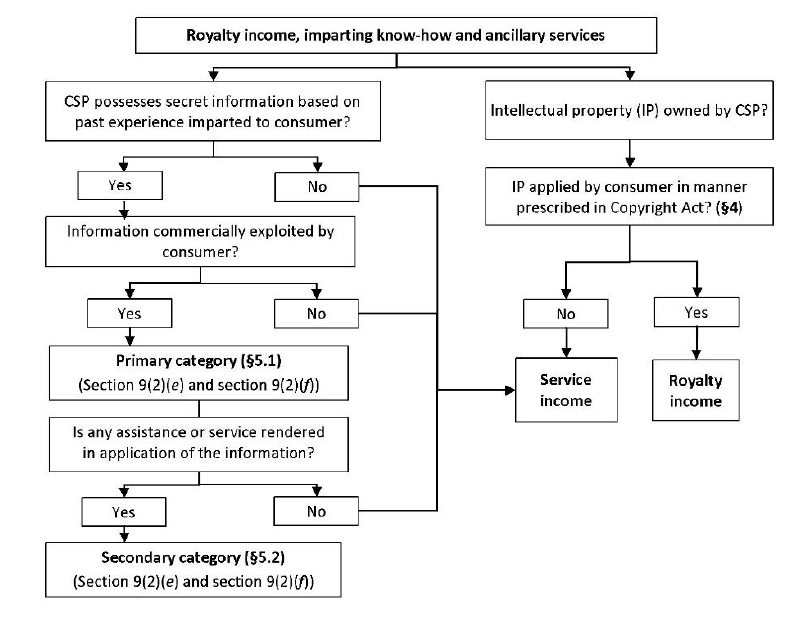
FIGURE 2: Summary of guidelines: income tax classification as royalty income or from the imparting of know-how and its ancillary services